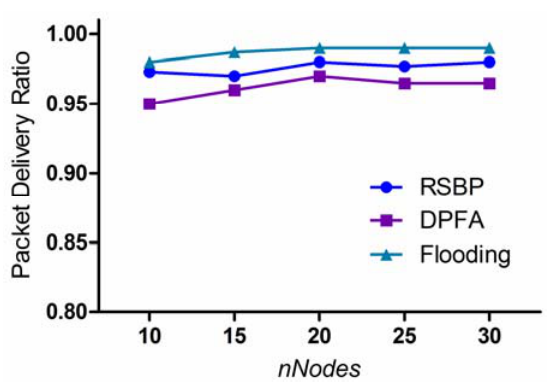
Figure 7. Packet delivery ratio.